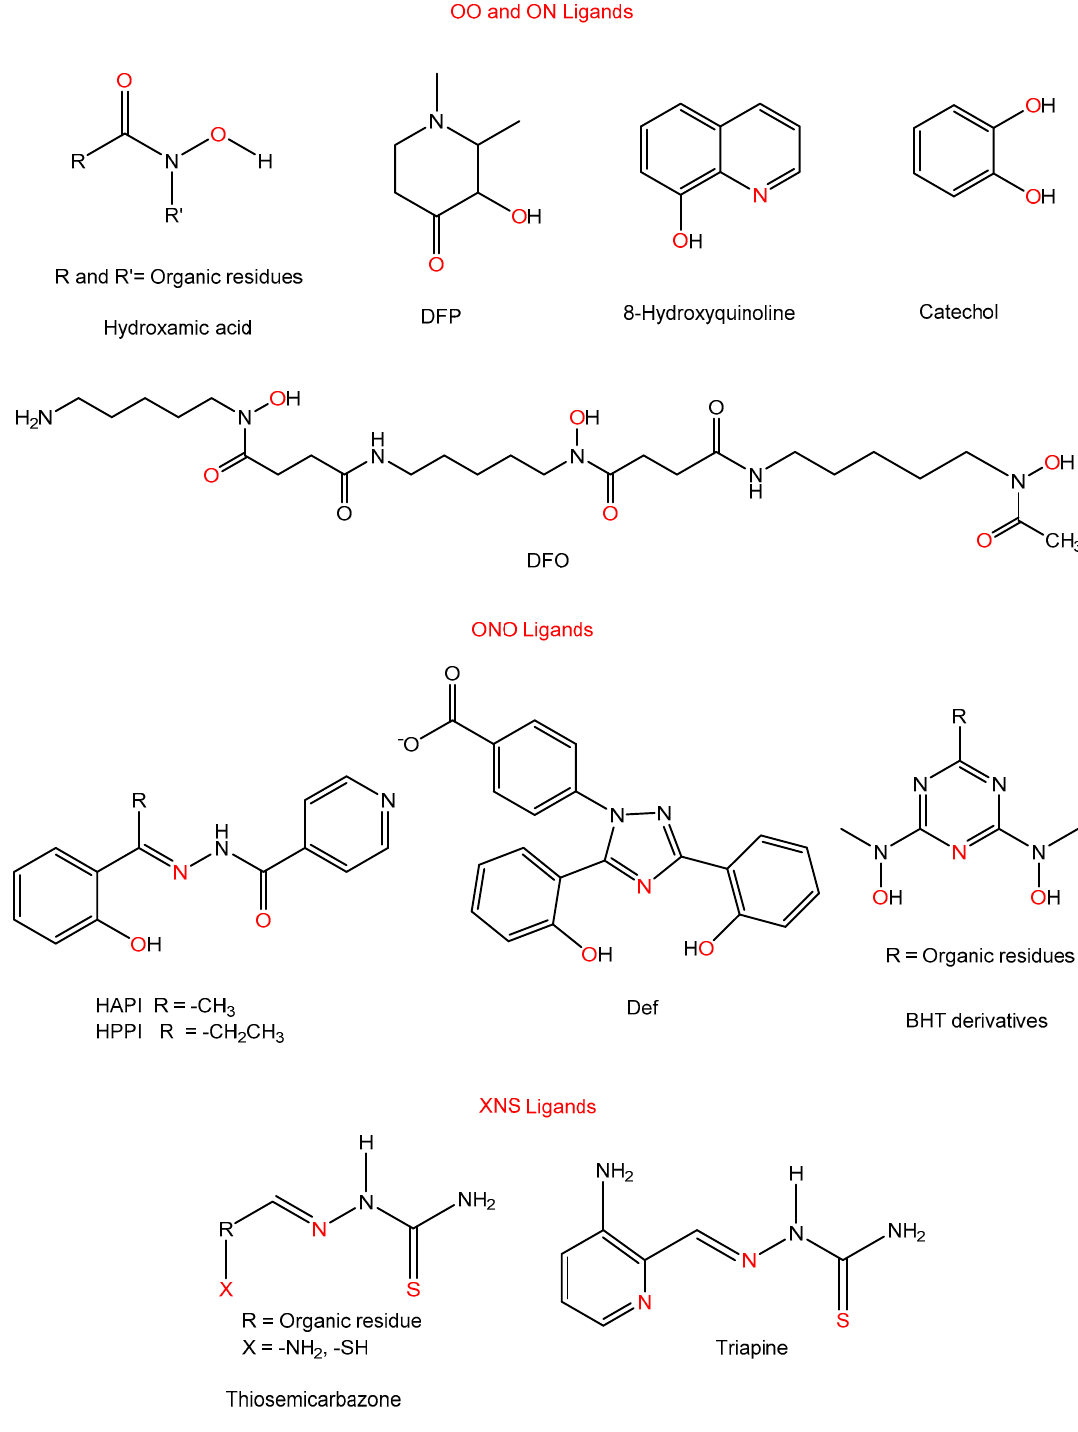
Figure 9. The structure of selected Fe chelators for potential anticancer application divided into the OO, ON, ONO, and XNS family of ligands. DFP: Deferiprone; DFO: Deferoxamine; BHT: 2,6- bis[hydroxy-(methyl)amino]-1,3,5-triazine; HAPI: ( E )- N ′ -[1-(2-hydroxyphenyl)ethylidene]- isonicotinoylhydrazide; HPPI: ( E )- N ′ -[1-(2-hydroxyphenyl)propylidene]isonicotinoylhydrazide.